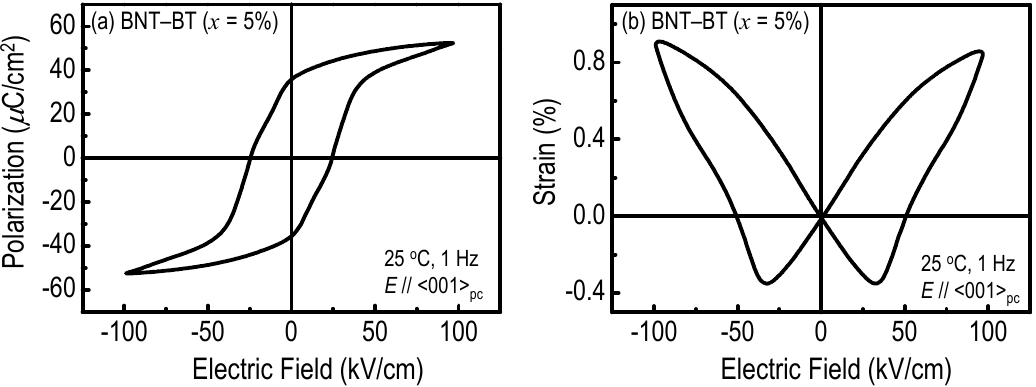
Figure 4. ( a ) Polarization-electric field [ P ( E )] hysteresis loop and ( b ) bipolar